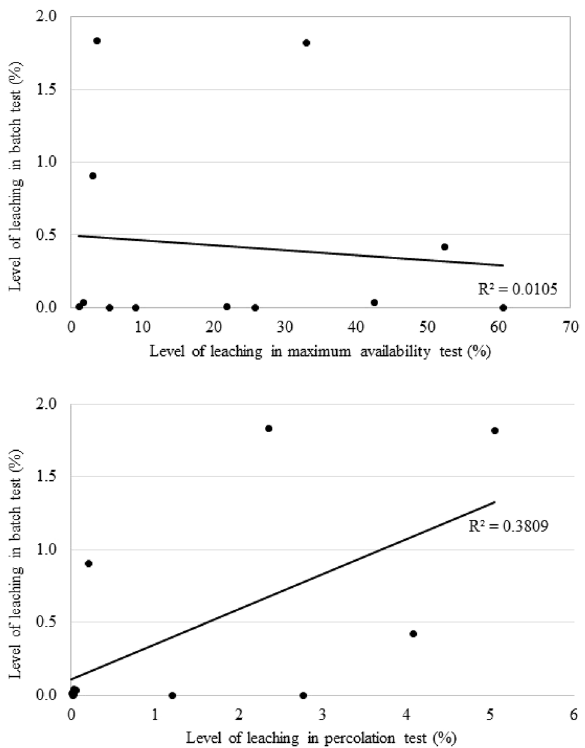
Figure 1. Correlation among the batch test results and maximum availability test as well as percolation test results relative to the total heavy metal contents in